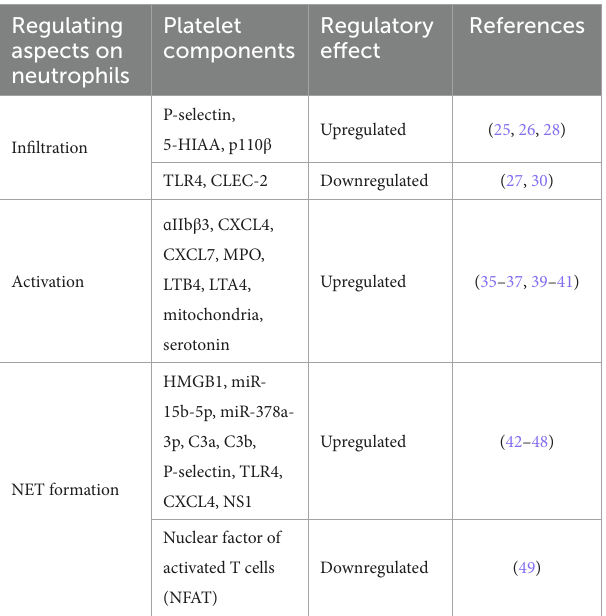
TABLE 1 Platelet-derived molecules affect the function of